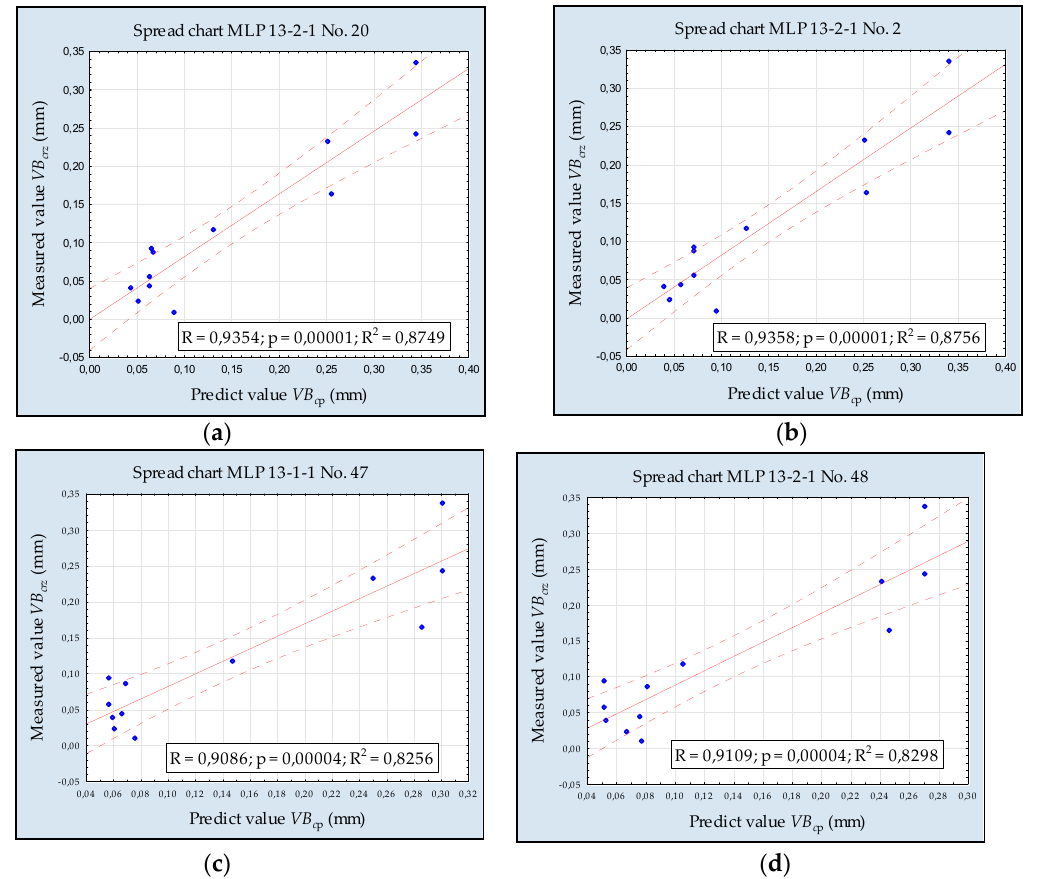
Figure 8. Verification model of ( a ) MLP No. 20, ( b ) MLP No. 2, ( c ) MLP No. 47 and, ( d ) MLP No. 48.